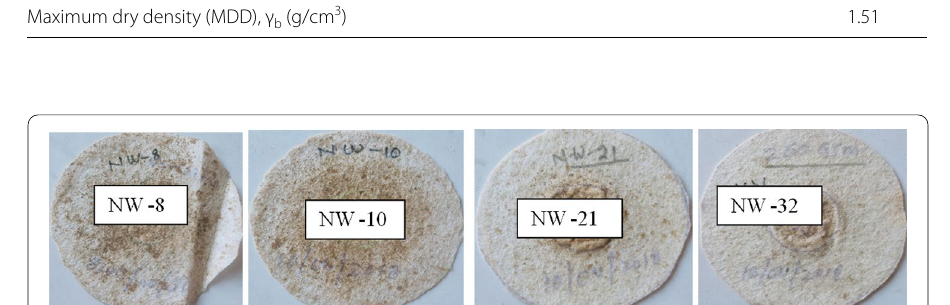
Fig. 1 Thermally bonded nonwoven geotextiles